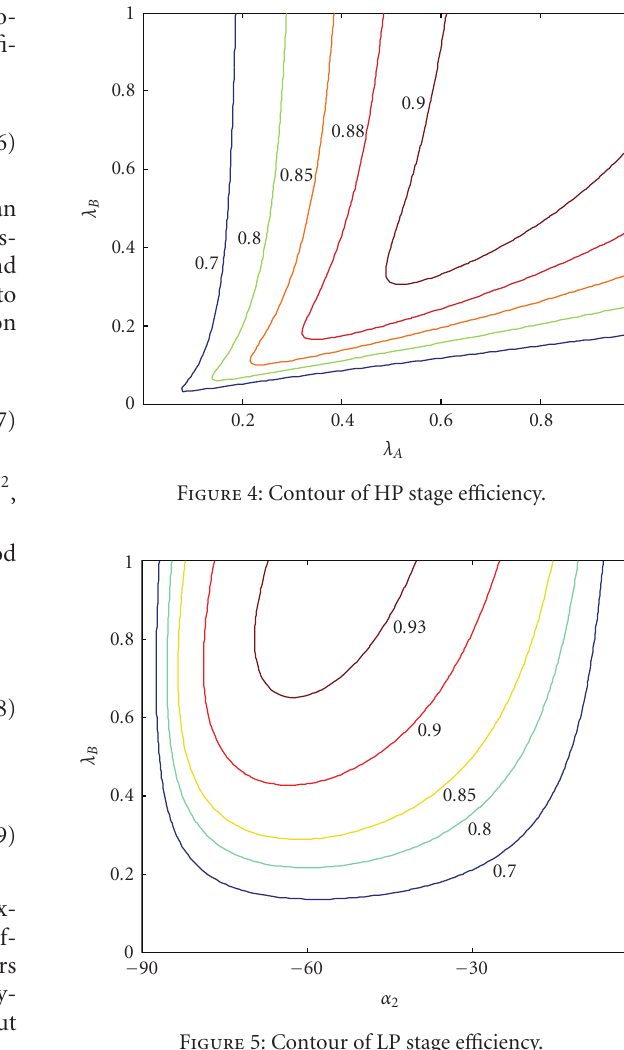
Figure 5: Contour of LP stage e ffi